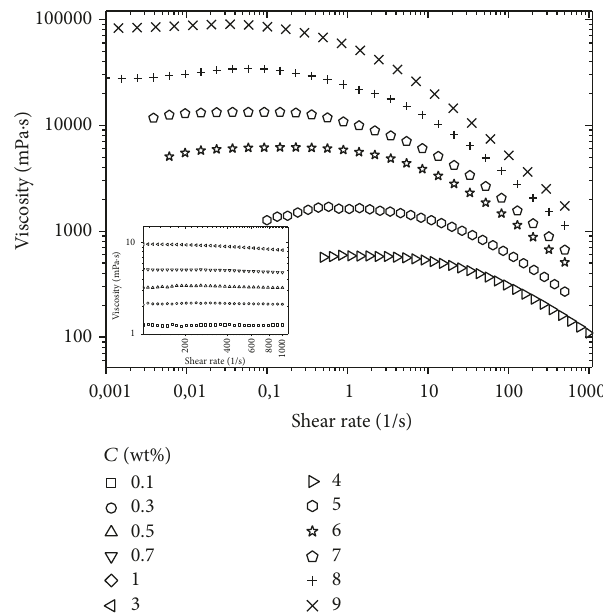
Figure 9: Variation of the viscosity as a function the shear rate for various concentrations of PAM-co-DAM.